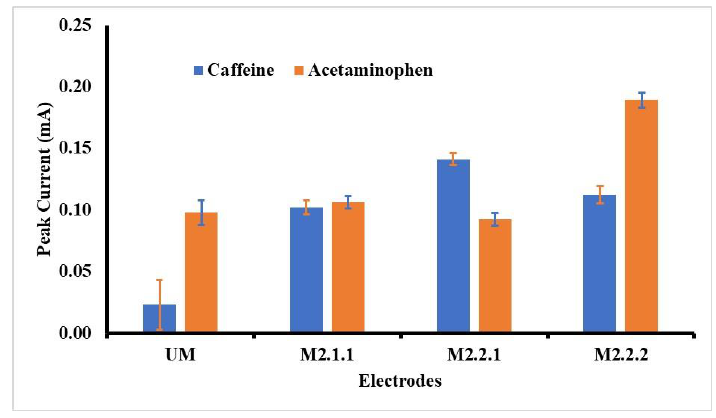
Figure 4. Observed peak currents for acetaminophen and caffeine 1 mM in BR buffer pH 7, on various working electrodes: GCE-UM (unmodified GCE), GCE-M211 (GCE modified by M211), GCE-M221 (GCE modified by M221), GCE-M222 (GCE modified by M222). Table 2. Peak potential for oxidation of acetaminophen and caffeine using working electrodes: unmodified glassy carbon electrode (GCE-UM), GCE-M211, GCE-M221 and GCE-M222. Peak Potential/(volt) vs. Ag/AgCl Electrode Acetaminophen